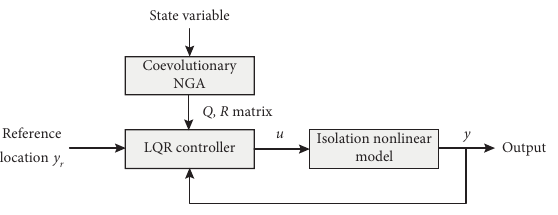
Figure 6: Simulation diagram with the proposed active control method.